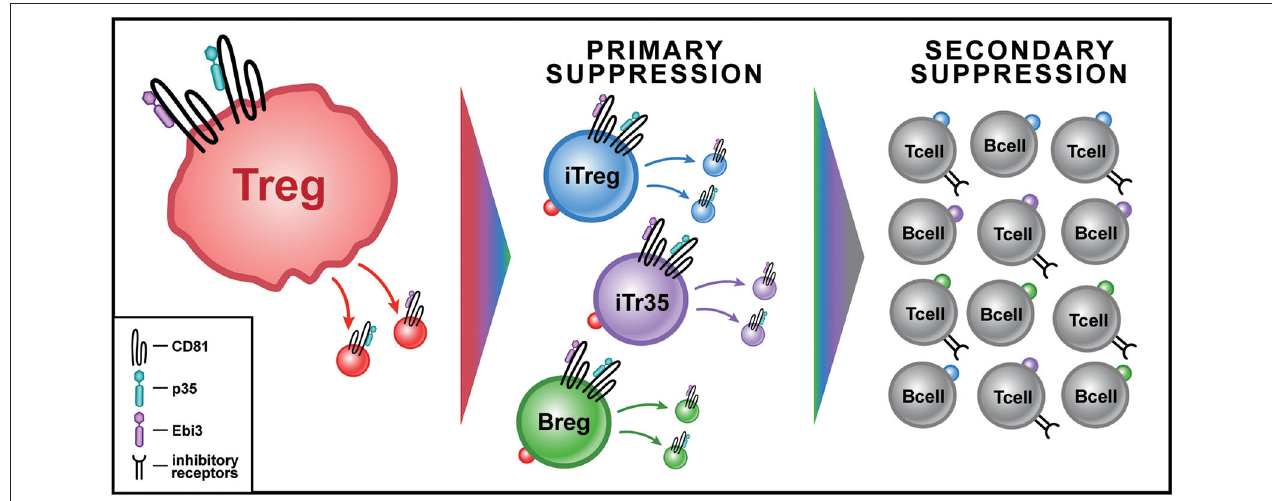
FIGURE 2 | Model for IL-35 + EV-Associated Infectious Tolerance from Tregs in Transplantation. Treg cells (red) produce IL-35 + EVs in response to antigenic stimulation. IL-35 + EVs are bound by lymphoid cells at their IL-35 receptor leading to primary suppression. The primary suppression by IL-35 + EVs of conventional CD4T cells causes some to express Foxp3, becoming inducible Tregs (iTregs-blue) that produce IL35 + EVs, while others become non-Foxp3 + IL-35 + EV producers (iTr35-purple); IL-35 + EVs can also induce Bregs (green) to produce their own IL-35 + EVs. Secondary suppression by IL35 + EV acquiring cells leads to an exponential increase in the cytokine’s impact. This can occur through both an increase in inhibitory receptor expression, including PD-1, LAG3, and TIM3, in addition to bystander suppression of local T cell function.